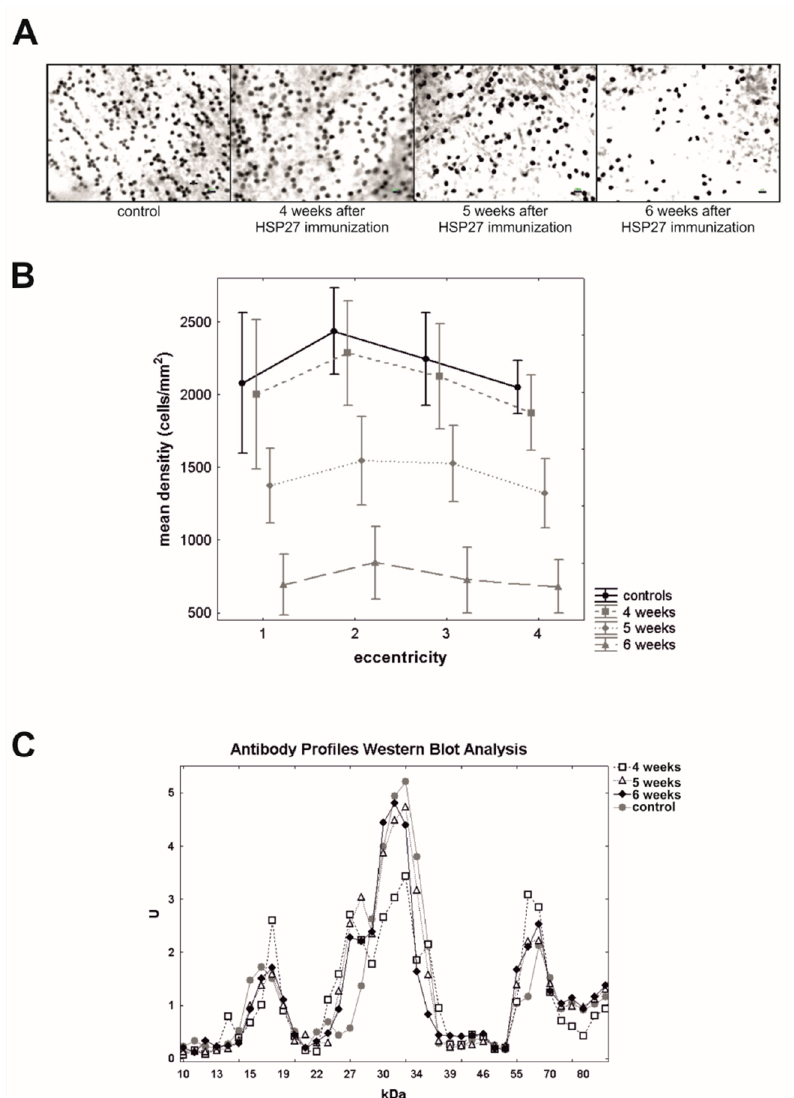
Figure 2. ( A ) Exemplary retinal flatmounts labeled with Brn3a from control rats and animals, which were immunized with HSP27 after four, five, and six weeks. ( B ) Mean retinal ganglion cell density of immunized rats after four, five, and six weeks, and control animals were plotted for four different eccentricities from the optic nerve head (1 = closest to optic nerve head). Five and six weeks after immunizations, animals expressed a lower retinal ganglion cell density. ( C ) At four, five, and six weeks, mean antigen-antibody reactivity of the serum of HSP27 and control animals was plotted against the corresponding molecular weight of the retinal antigen and revealed, e.g., a significant up- and down-regulations of certain antibodies reactivities. Scale bar = 10 µm [46].